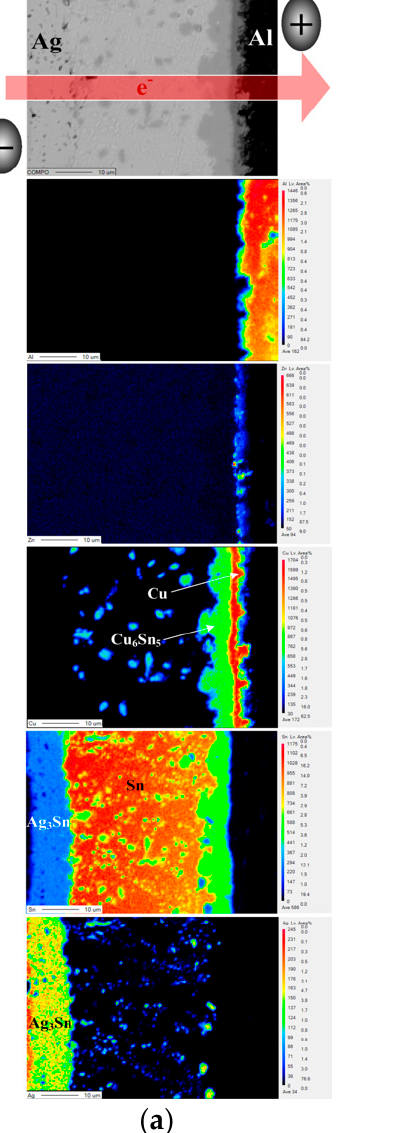
Figure 4. EMPA images of the EP PV module after biasing for 72 h: ( a ) Ag-direction, ( b ) Al-direction.